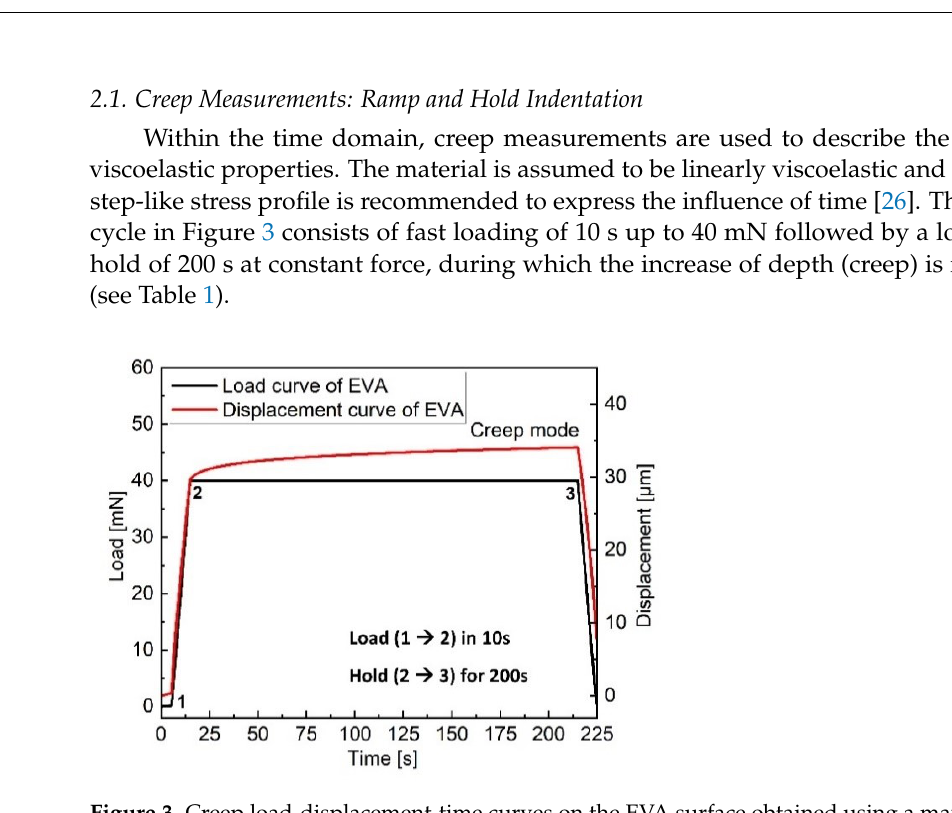
Figure 3. Creep load-displacement-time curves on the EVA surface obtained using a maximum load 40 mN, duration of creep 200 s. Table 1. Indentation parameters for creep mode.